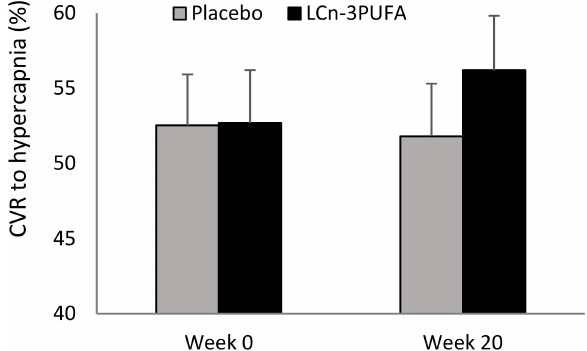
Figure 2. CVR to hypercapnia at baseline and end of intervention in placebo and LCn-3PUFA groups.